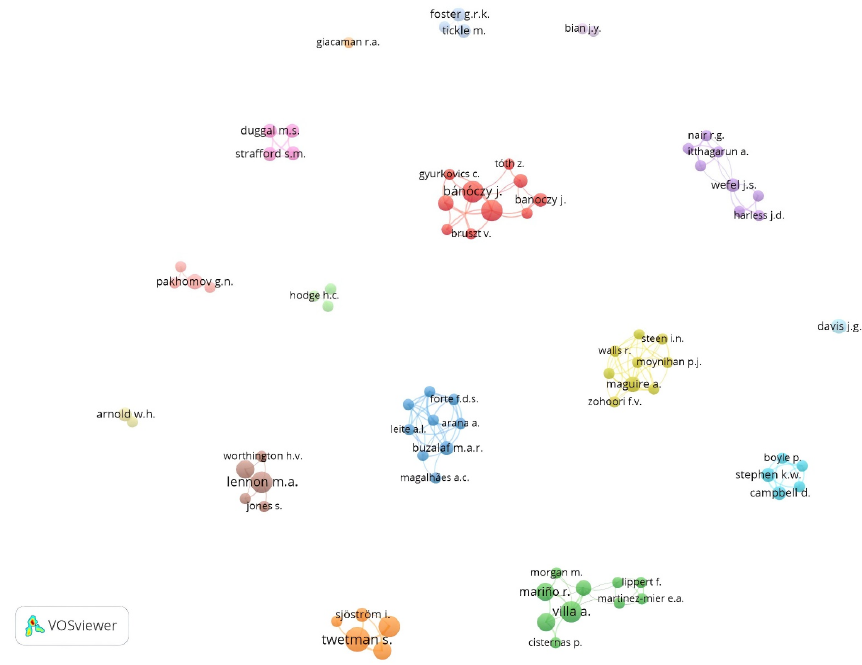
Figure 7. Network visualization of co-authorship among authors.